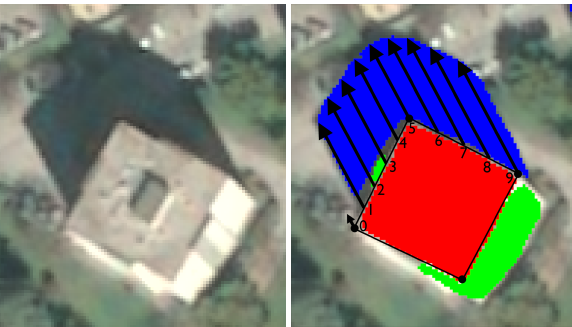
Figure 9. Left: input image, right: predicted masks for rooftop, facades, shadow, and shadow rays to compute shadow length.